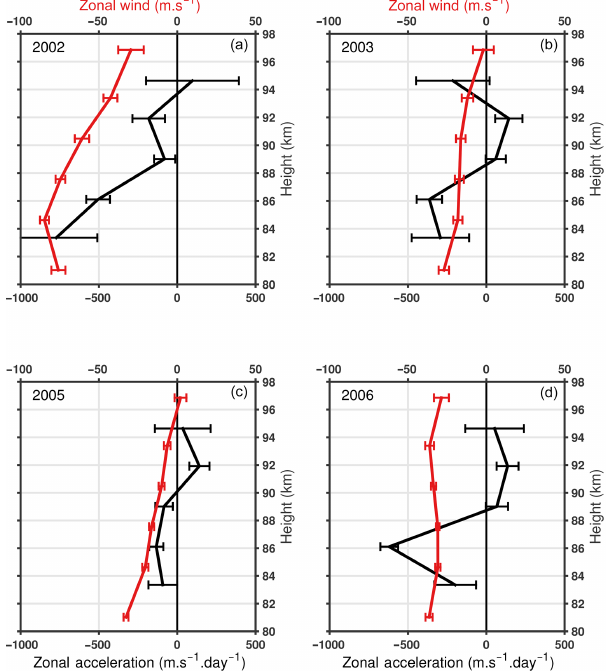
Figure 4. Variation of monthly-mean zonal wind (red) and monthly- mean zonal acceleration (black) with height at the time of maxi- mum acceleration during the first westward phase of the MSAO for (a) 2002, (b) 2003, (c) 2004 and (d) 2005. The errors on wind values have been multiplied by 10 to make them more visible